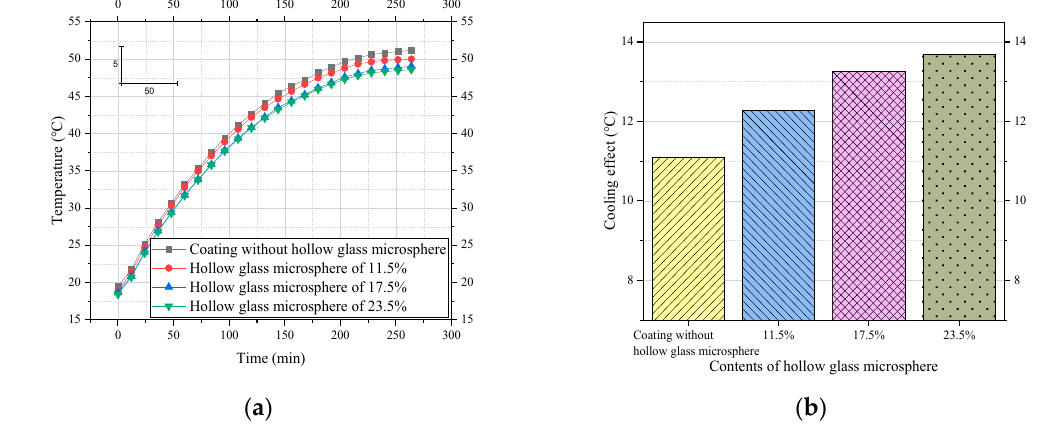
Figure 9. Effect of hollow glass microbeads on the cooling performance of coatings. ( a ) Process of heating to thermal equilibrium; ( b ) comparison of cooling effects .